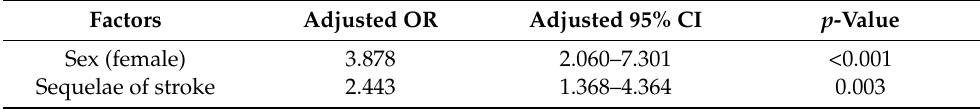
Table 4. Multivariable logistic regression analysis of the factors affecting depression in stroke patients retrieved from the Korea National Health and Nutrition Examination Survey (KNHANES) (2016–